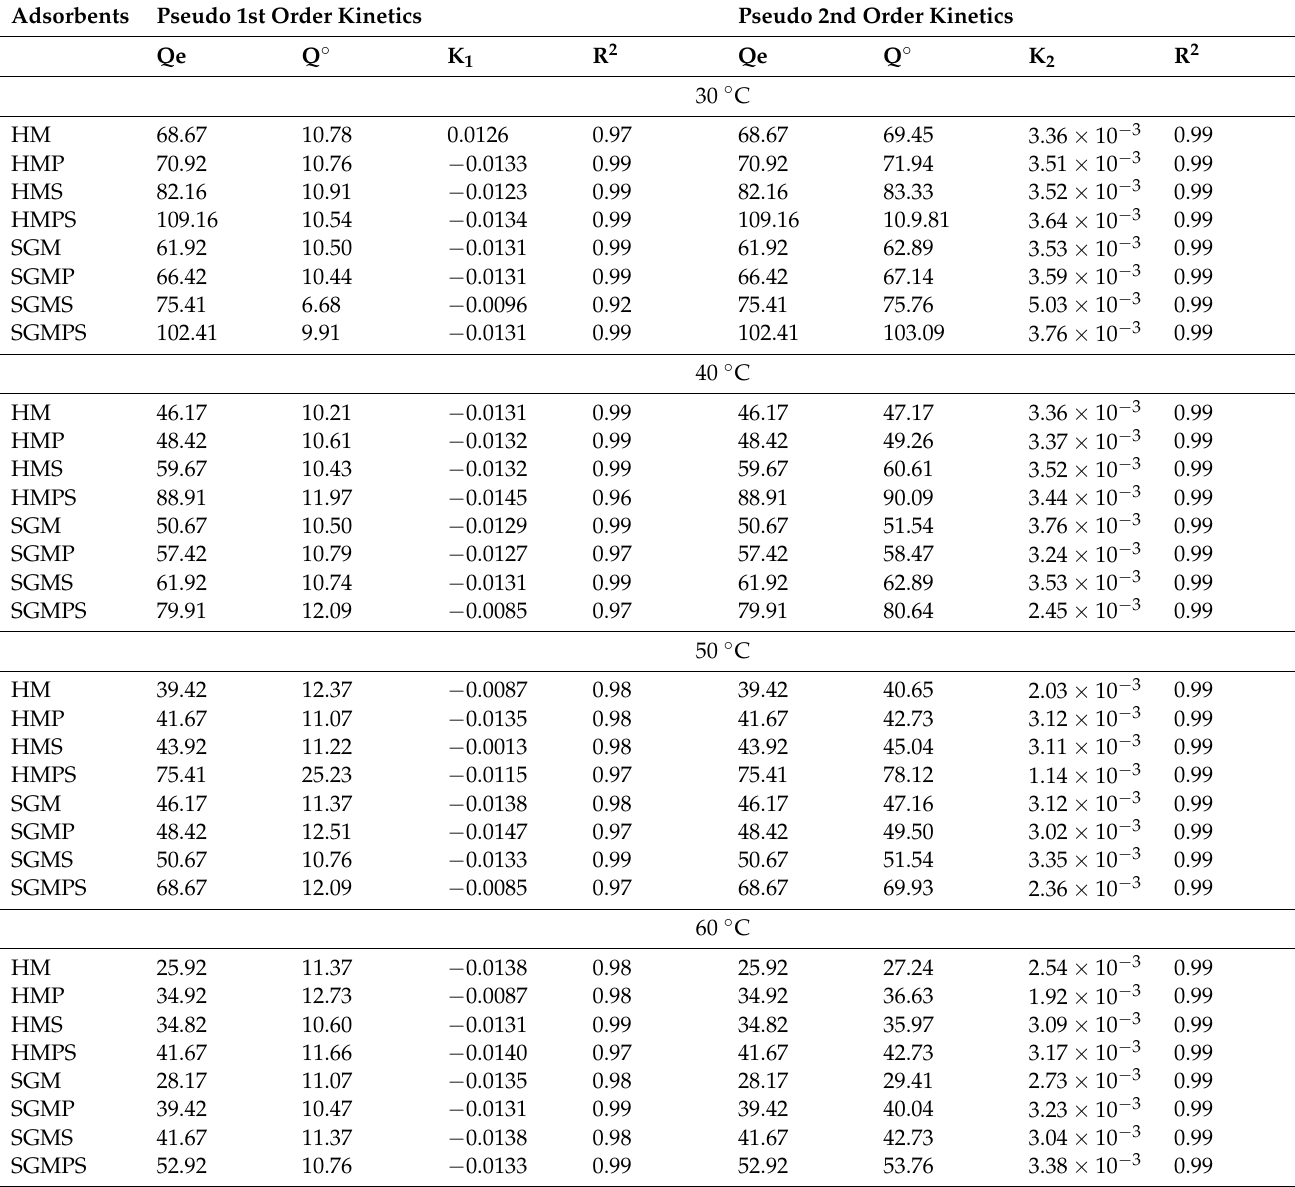
Table 2. A comparison of pseudo 1st order kinetics and 2nd order kinetics models for describing adsorption data of direct violet 51 dye using hoshanar and sunny grey marble waste composites at different